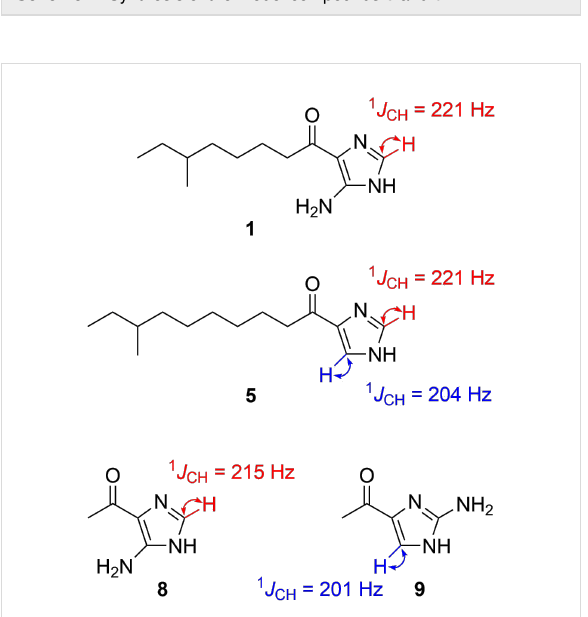
Scheme 1: Synthesis of the model compounds 8 and 9 .